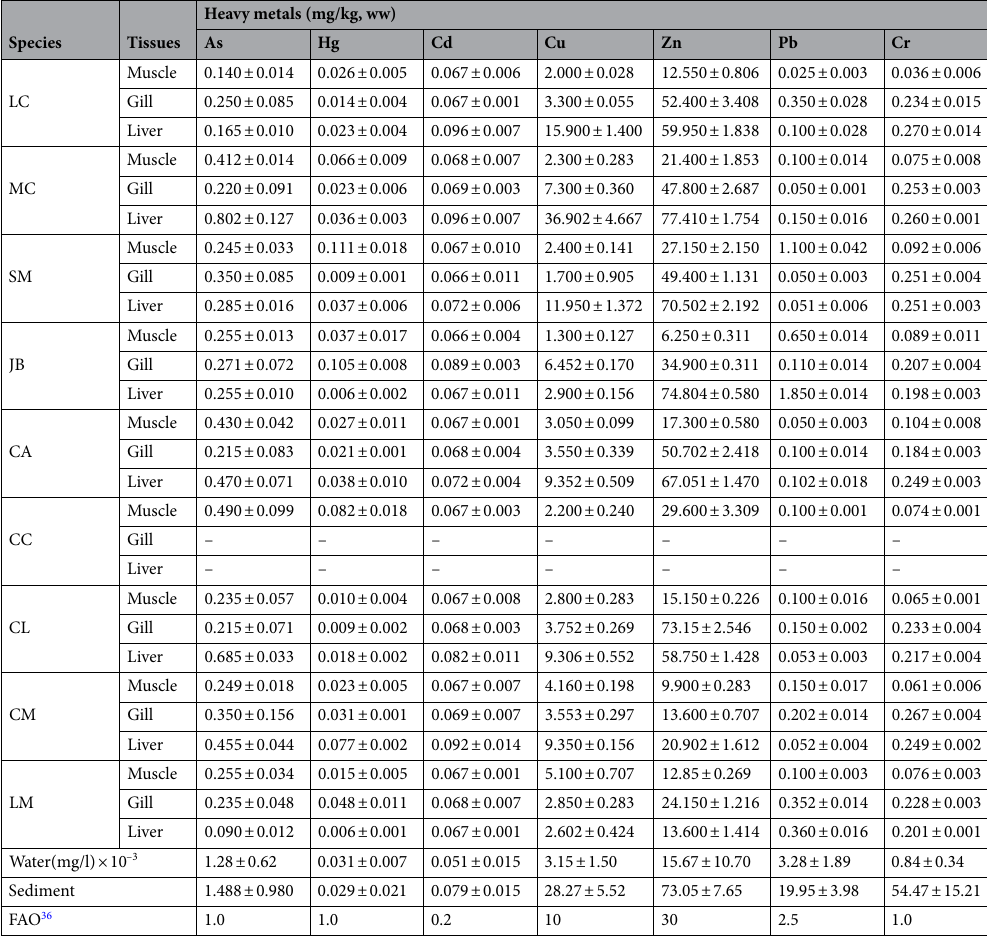
Table 3. Concentration of heavy metals of fish and marine environment. The gills and liver of the CC were not sampled. The levels indicated by the FAO are for fish.